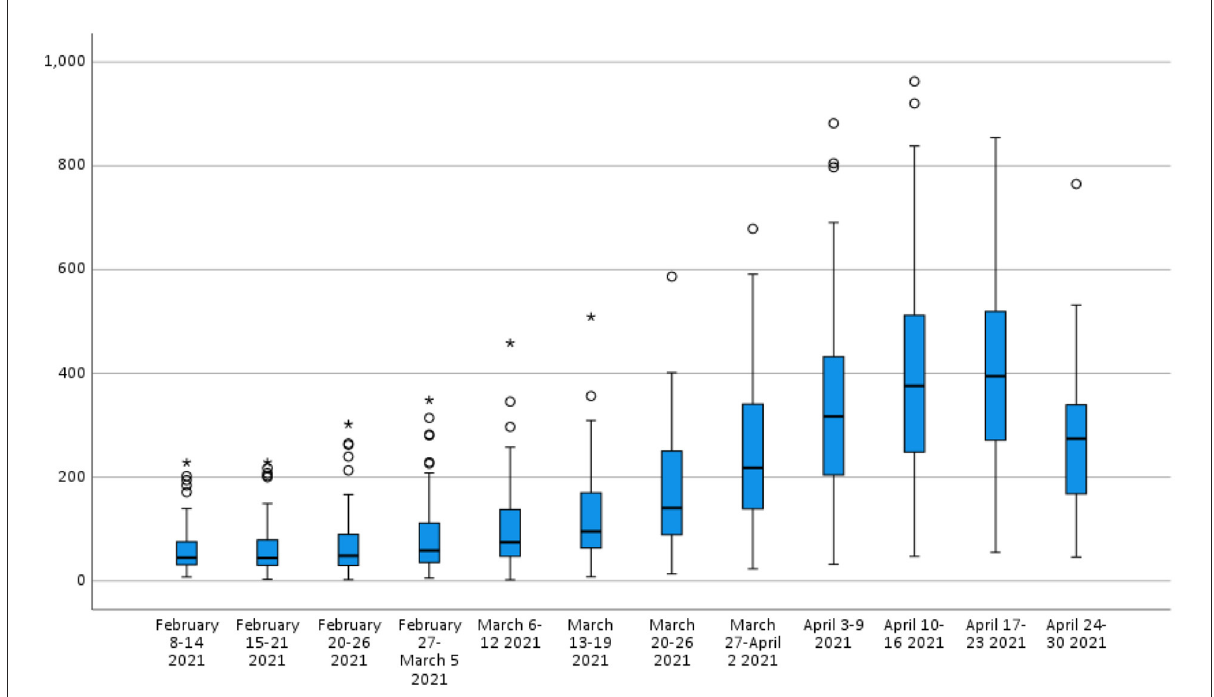
FIGURE4 The attack rates of COVID-19 (per 1,00,000 population) by the provinces in